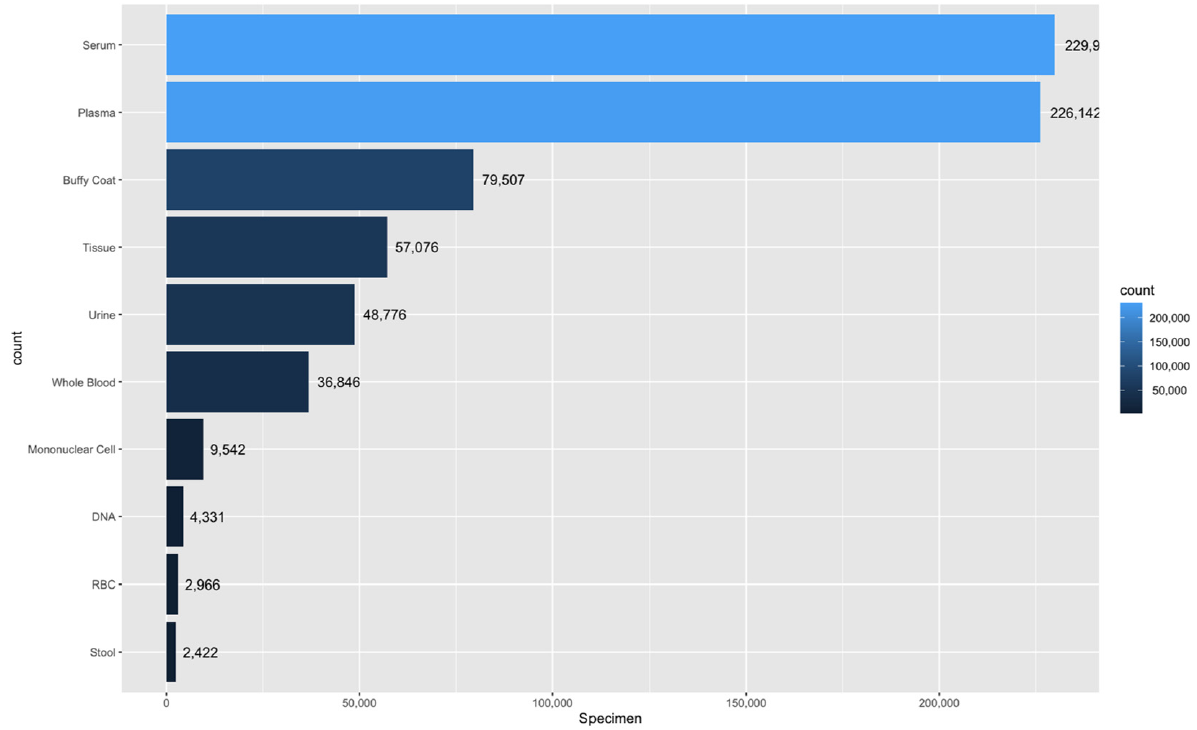
Figure 7. Specimen count.